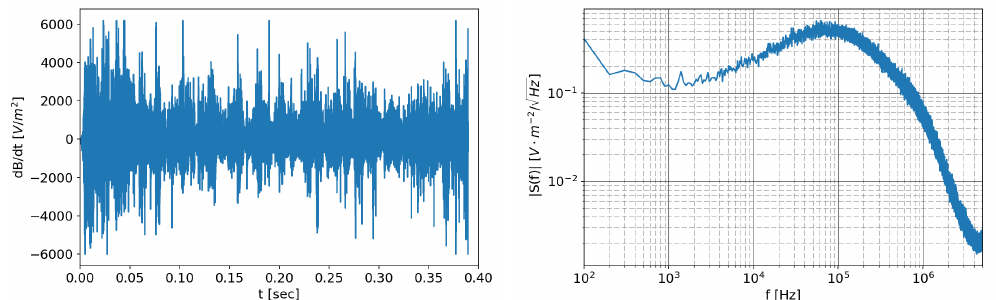
Figure 13. dB / dt signal of the toroidal field component from an in-vessel wide bandwidth probe from a reversed field pinch pulse at 1.5 MA in RFXmod: ( left ) signal; and ( right )